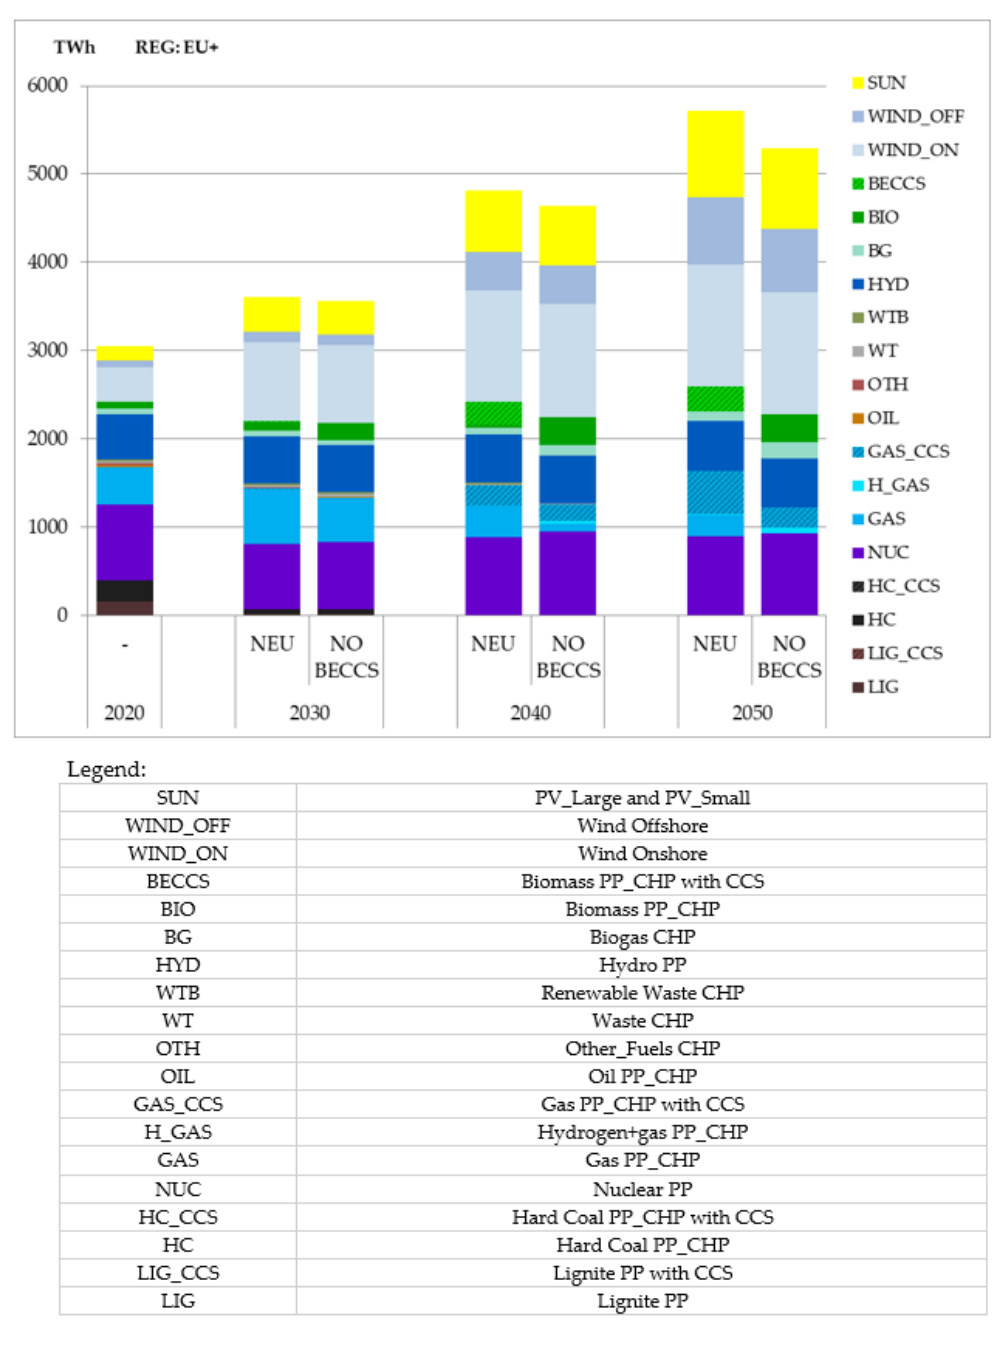
Figure 5. Electricity generation by fuels and sources in the EU+ (in MWh). Source: own calculations based on MEESA model results.